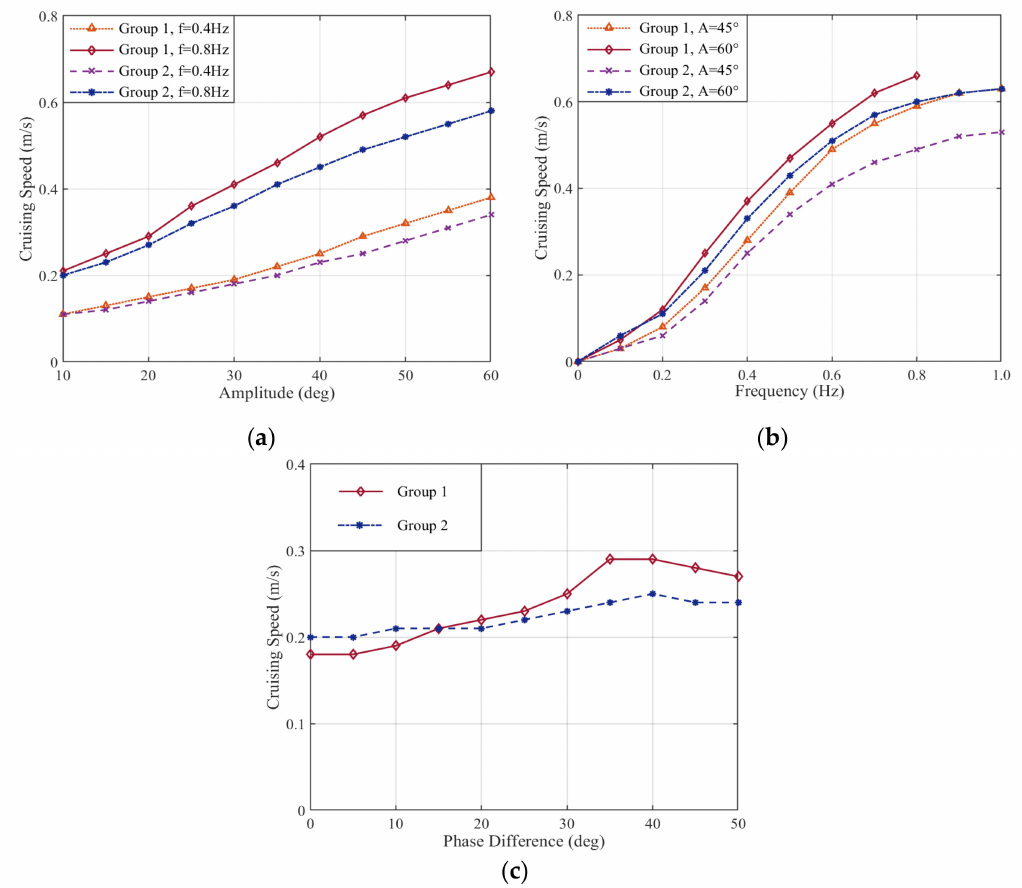
Figure 9. Cruising performance comparison of different fin groups. ( a ) Relationship between speed and amplitude; ( b ) relationship between speed and frequency; ( c ) relationship between speed and phase